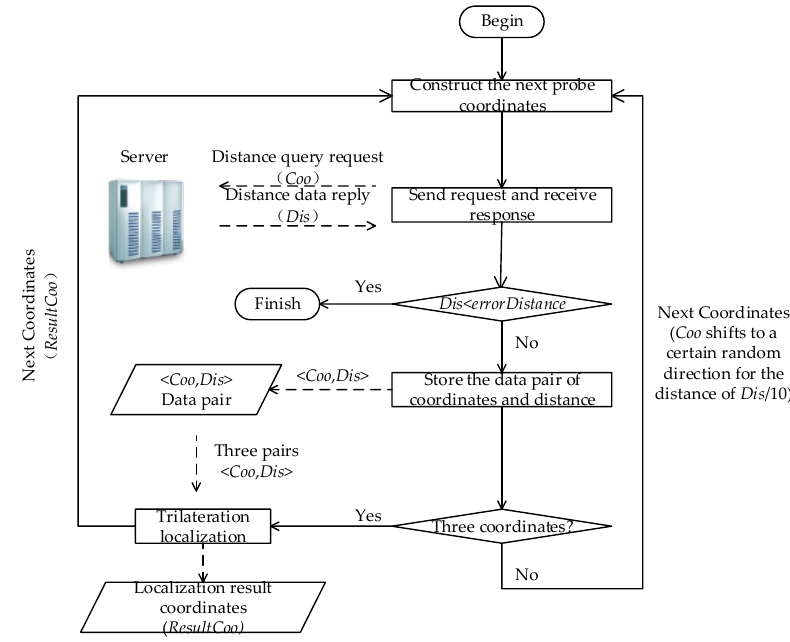
Figure 18. Flowchart of trilateration localization.